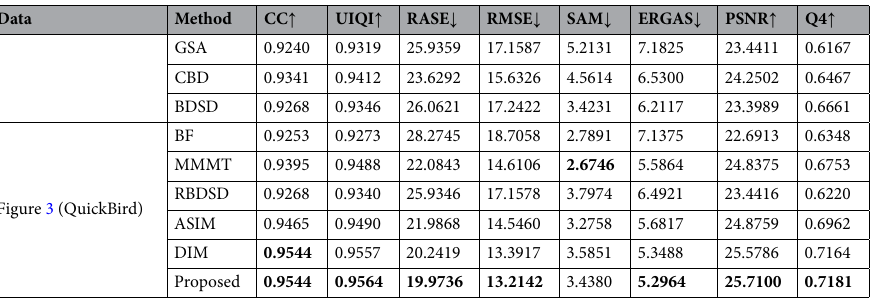
Table 4. Objective evaluation of the simulation experimental results shown in Fig. 3. Significant values are in [bold].